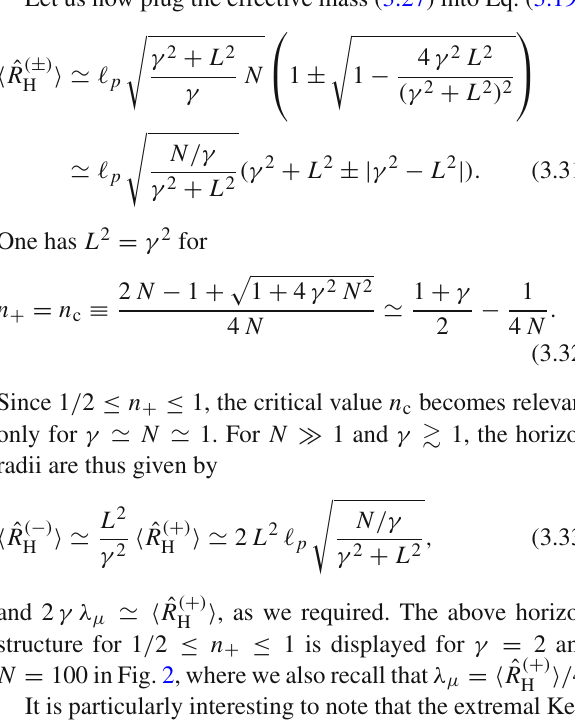
(cid:6) for λ μ = H H